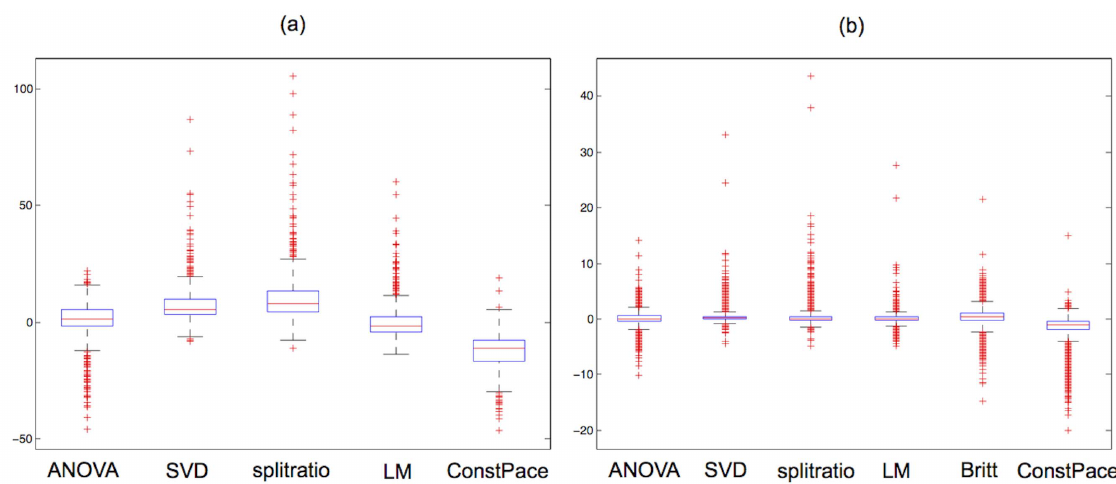
Figure 6. 2013 prediction error box plots. Boxplots of differences in predicted finishing times between the KNN method and other methods for participants in the 2013 Boston marathon, who passed the half-marathon mark, but did not complete the course. Predictions are based on (a) splits available up to 30 km or less (n=515) and (b) splits available up to 35 km or 40 km (n=5009). Note the scale difference between the two plots.